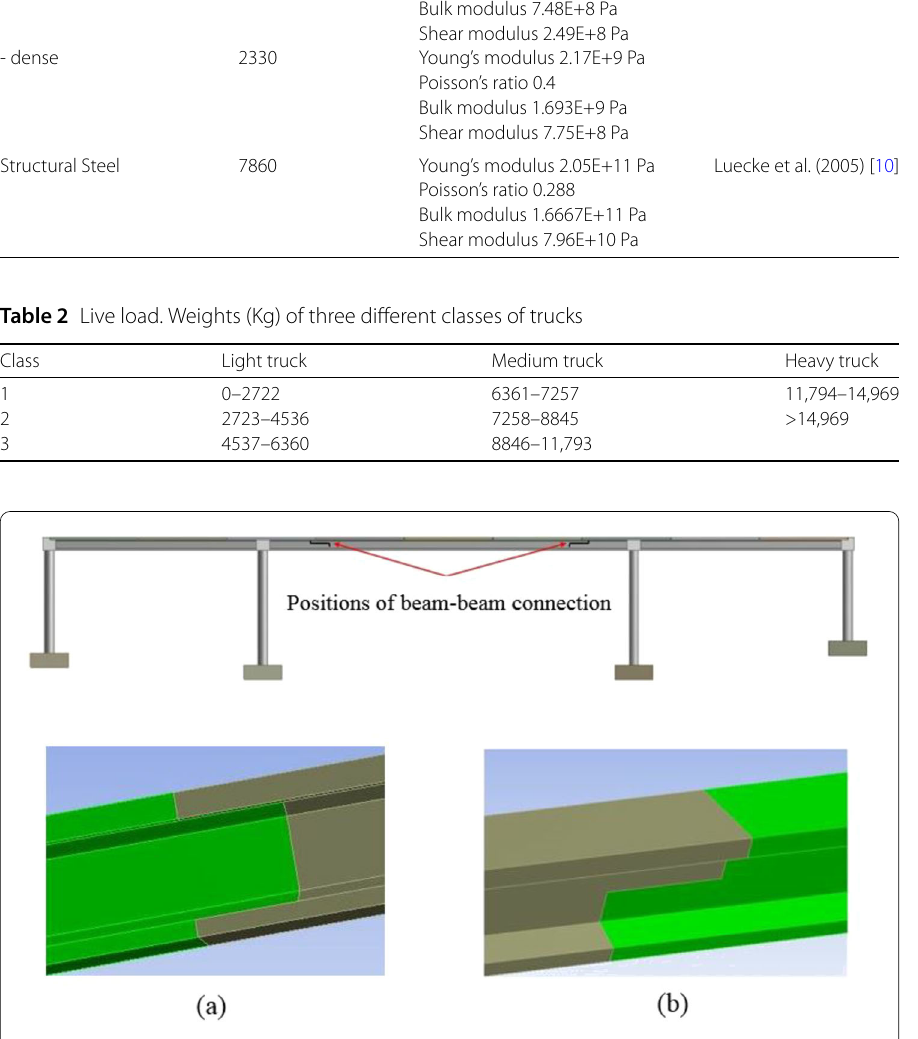
driven across the bridge. In this study, two medium trucks with the weight of 7258 kg are assumed to be driven at a constant speed of 60 km/h on each lane of the traffic. We assume that both trucks are to arrive and depart the bridge at the same time. We also apply a fixed support on the bottom surface of all foundation